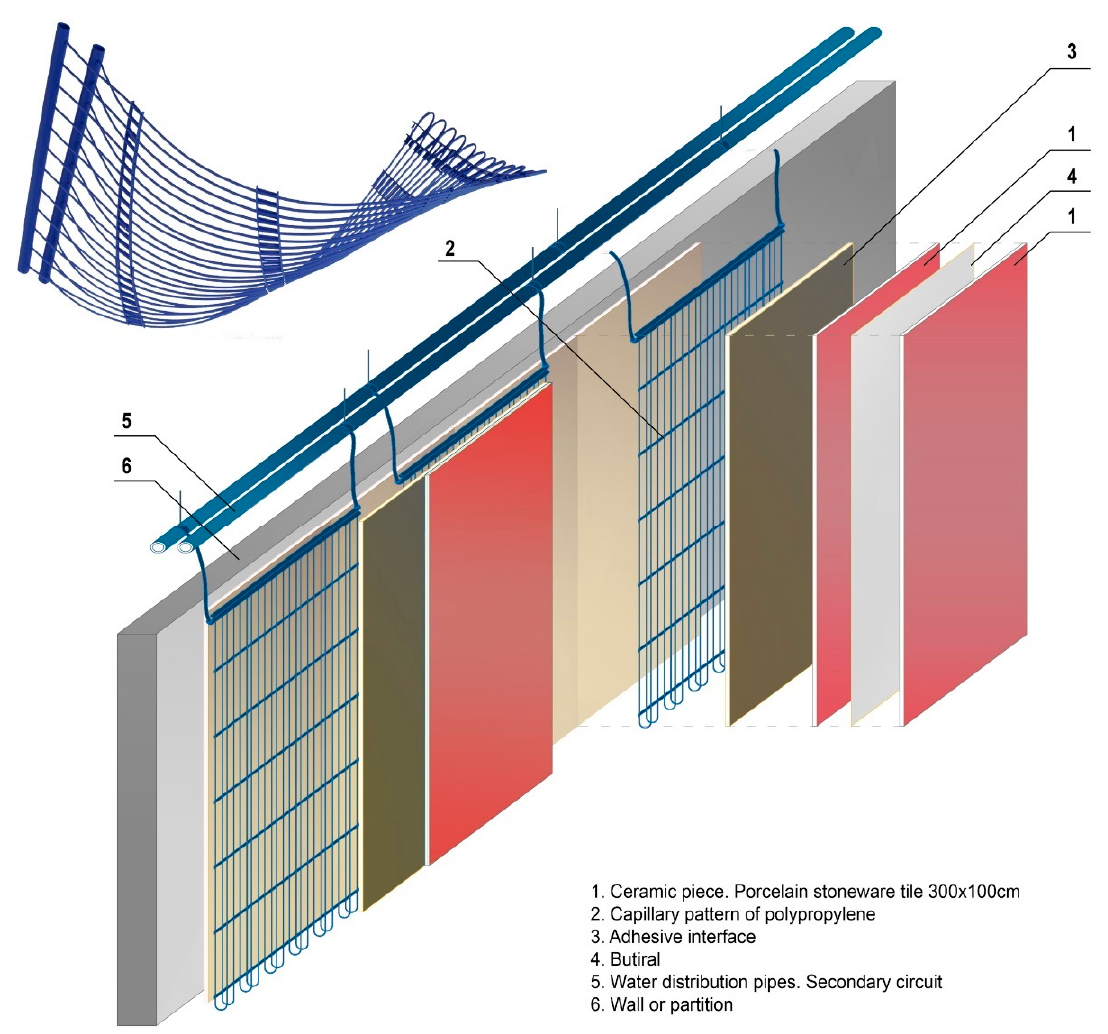
Figure 1. Patent application No. P201001626. Ceramic Thermal Conditioning Panel.